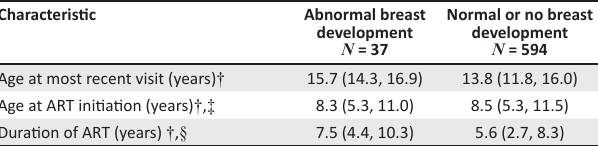
TABLE 1: Antiretroviral therapy clinic characteristics ( n =